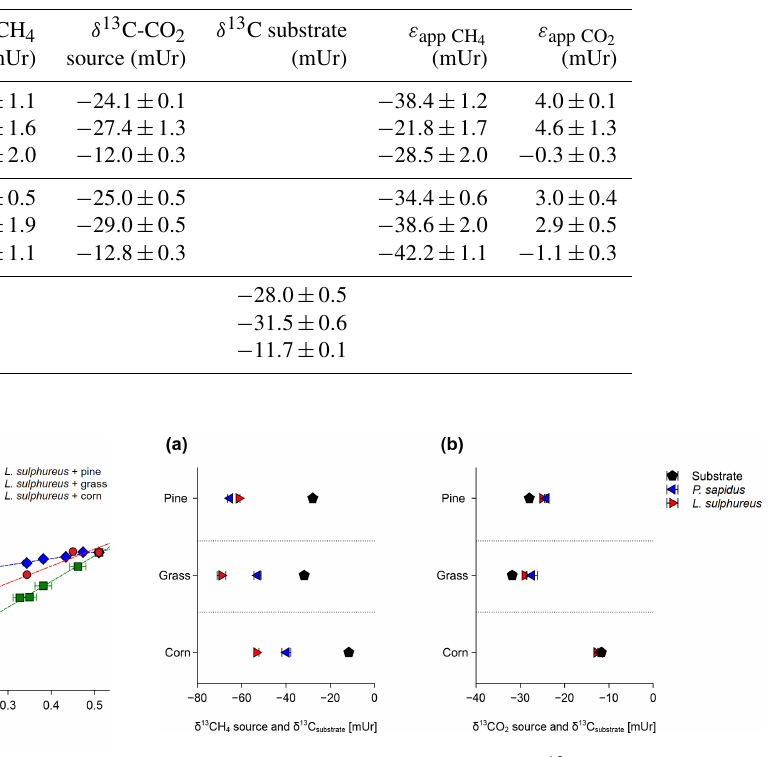
Figure 4. Calculated source signatures of δ 13 C-CH 4 values (a) and δ 13 C-CO 2 values (b) from P. sapidus , L. sulphureus as well as the δ 13 C values of the substrate. The data points represent the mean values of the individual Keeling plots with their standard deviation ( n =